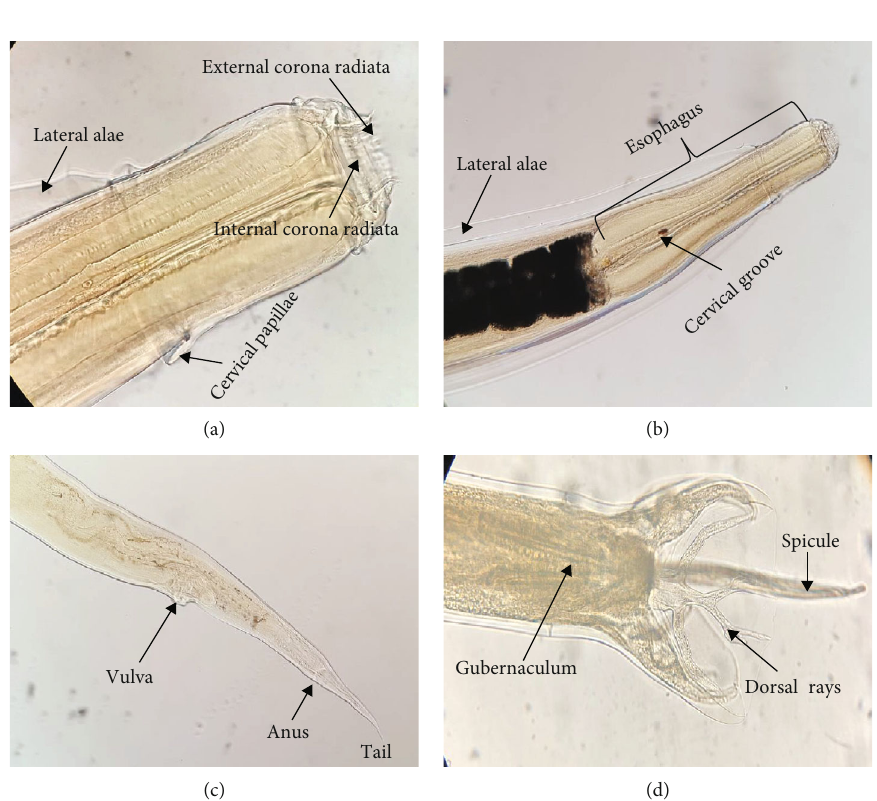
Figure 1: Oesophagostomum columbianum : (a, b) anterior end showing corona radiata and esophagus; (c) posterior end of female showing vulva and anus; (d) bursa of male showing dorsal rays and spicules. Table 2: Comparative measurement (in mm) of present Oesophagostomum columbianum isolated and those previously recorded. Body